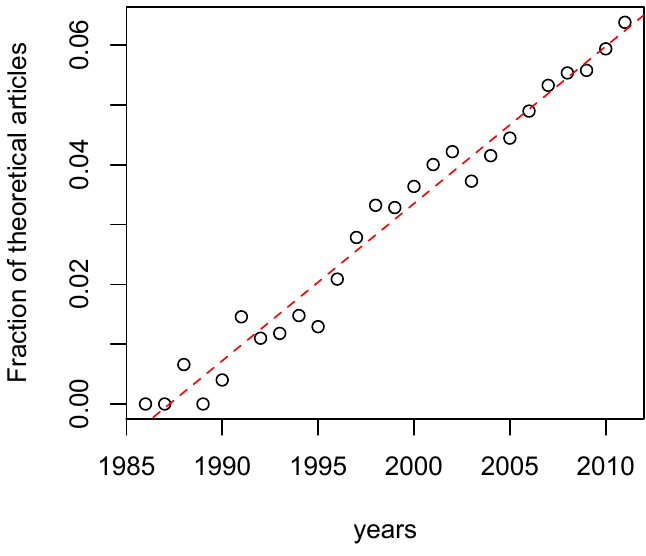
Figure 2. Fraction of articles on HIV that involve theoretical biology. The regression was highly significant ( r = 0 . 0027 , p-value < 10 − 3 and adj- R 2 = 0 . 97 ). The data was collected on Web of Science on July 13, 2012. The articles on HIV were selected using the keywords Topic=(HIV) AND Topic=(virus OR immunodefic*) and there were 110 , 064 hits. The restriction to theoretical articles was performed by adding the keyword AND Topic = (dynamics OR mathemat* OR computational) and there were 4 , 277